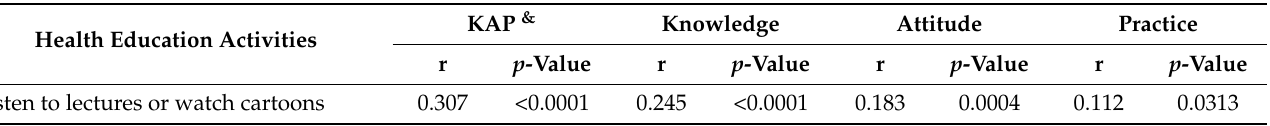
Table 3. The relationship between KAP score changes after intervention and health education activities of pupils in the intervention school.